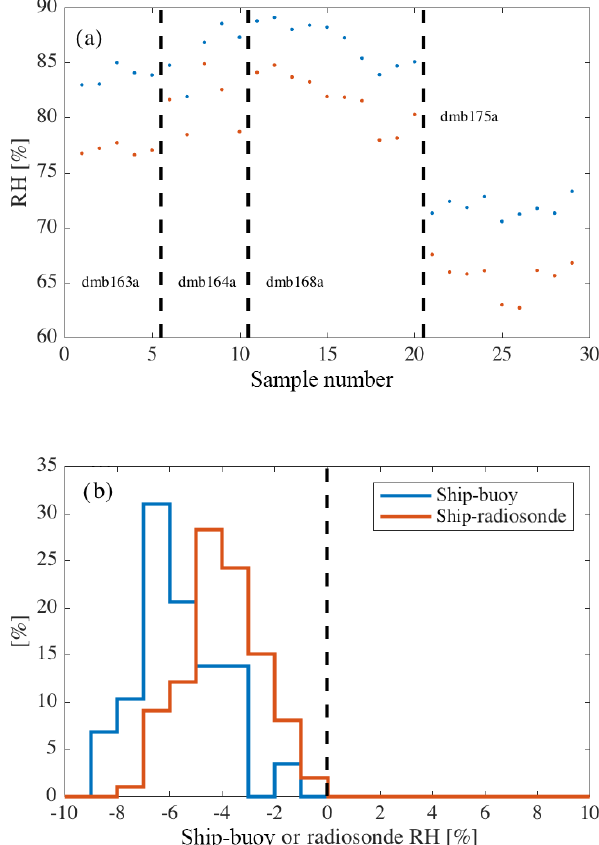
Figure 15. Comparisons between the RH measured by the ship and by a buoy when the ship was within 0.1 ◦ latitude/longitude of the buoy. All data are 10min averages; ship measurements are from 15m and buoy measurements from 3ma.s.l. (a) All avail- able observation pairs, with dashed vertical lines separating buoys: dmb163a (9 ◦ N, 140 ◦ W), dmb164a (5 ◦ N, 140 ◦ W), dmb168a (5 ◦ S, 140 ◦ W), and dmb175a (8 ◦ N, 125 ◦ W). (b) The distribution of all differences between paired ship and buoy RHs, together with the differences between 99 pairs of ship RH and radiosonde RH, the latter from